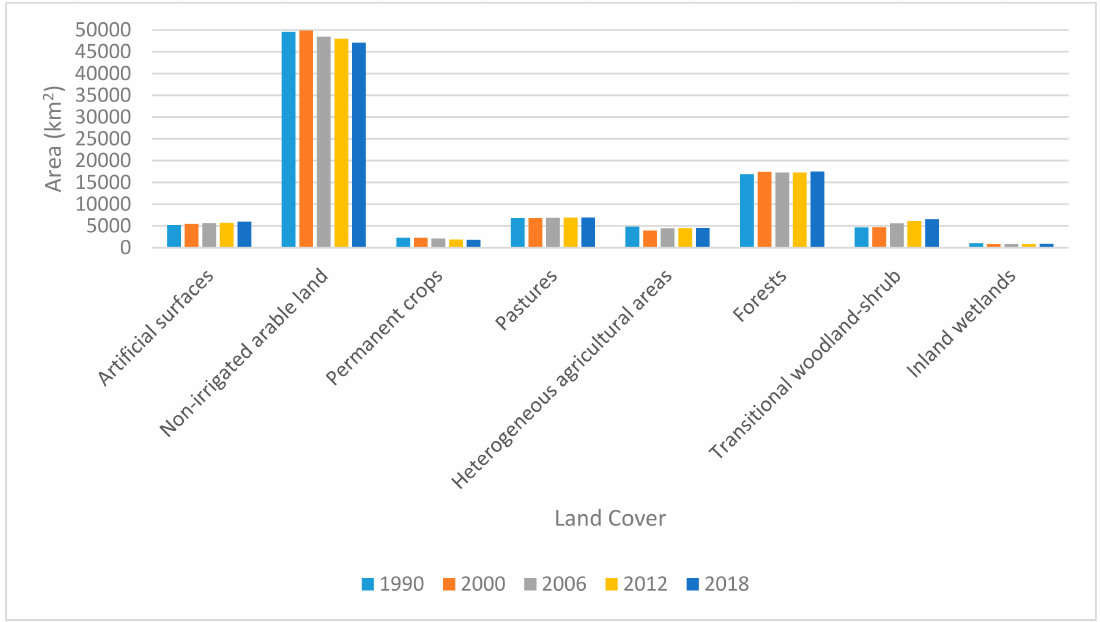
Figure 4. Land use and land cover (LULC) change over time by total